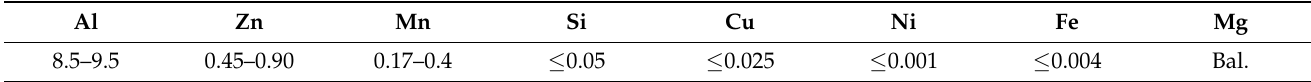
Table 1. The chemical composition (wt%) of AZ91D magnesium alloy.